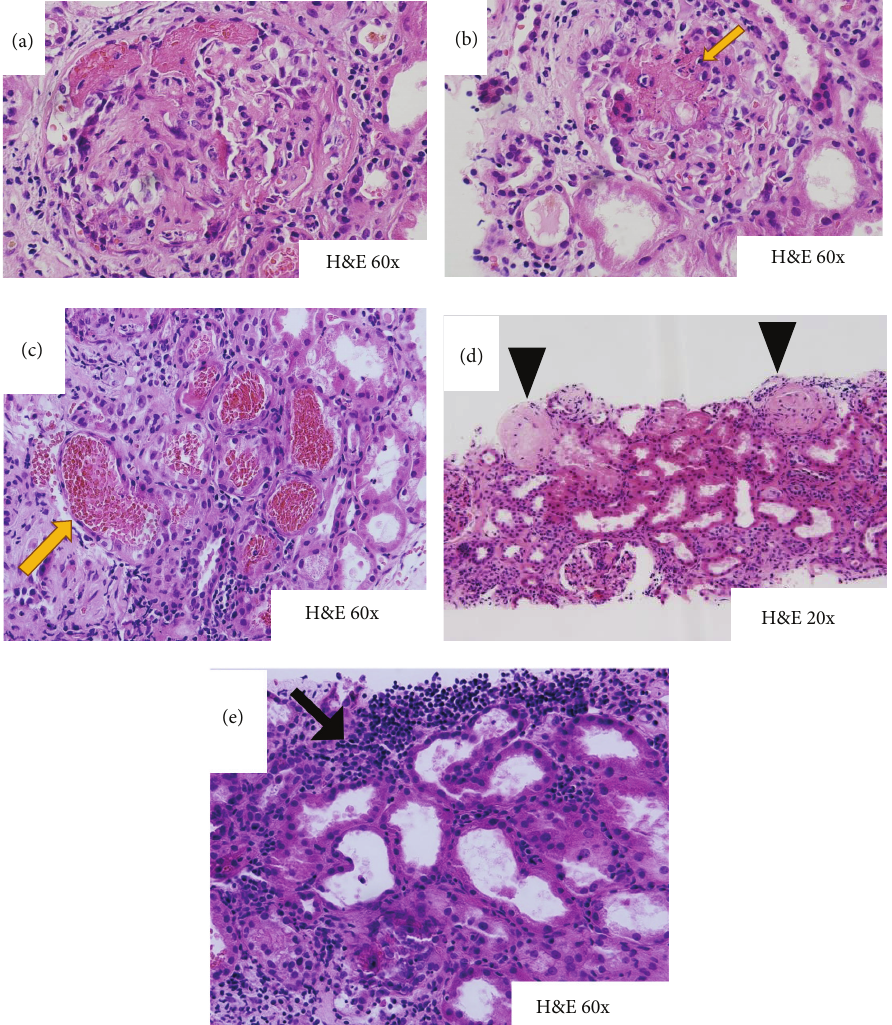
Figure 2: (a) Necrotizing glomerulonephritis with fibrocellular crescents (66%). (b) Global glomerulosclerosis (33%), focal infiltration of polymorphonuclear cells within the glomerulus (arrow). (c) Tubular hemorrhage (arrow). (d) Sclerosed glomeruli (arrow). (e) Interstitial inflammation lymphocytes, plasma cells, and polymorphonuclear cells (arrow).